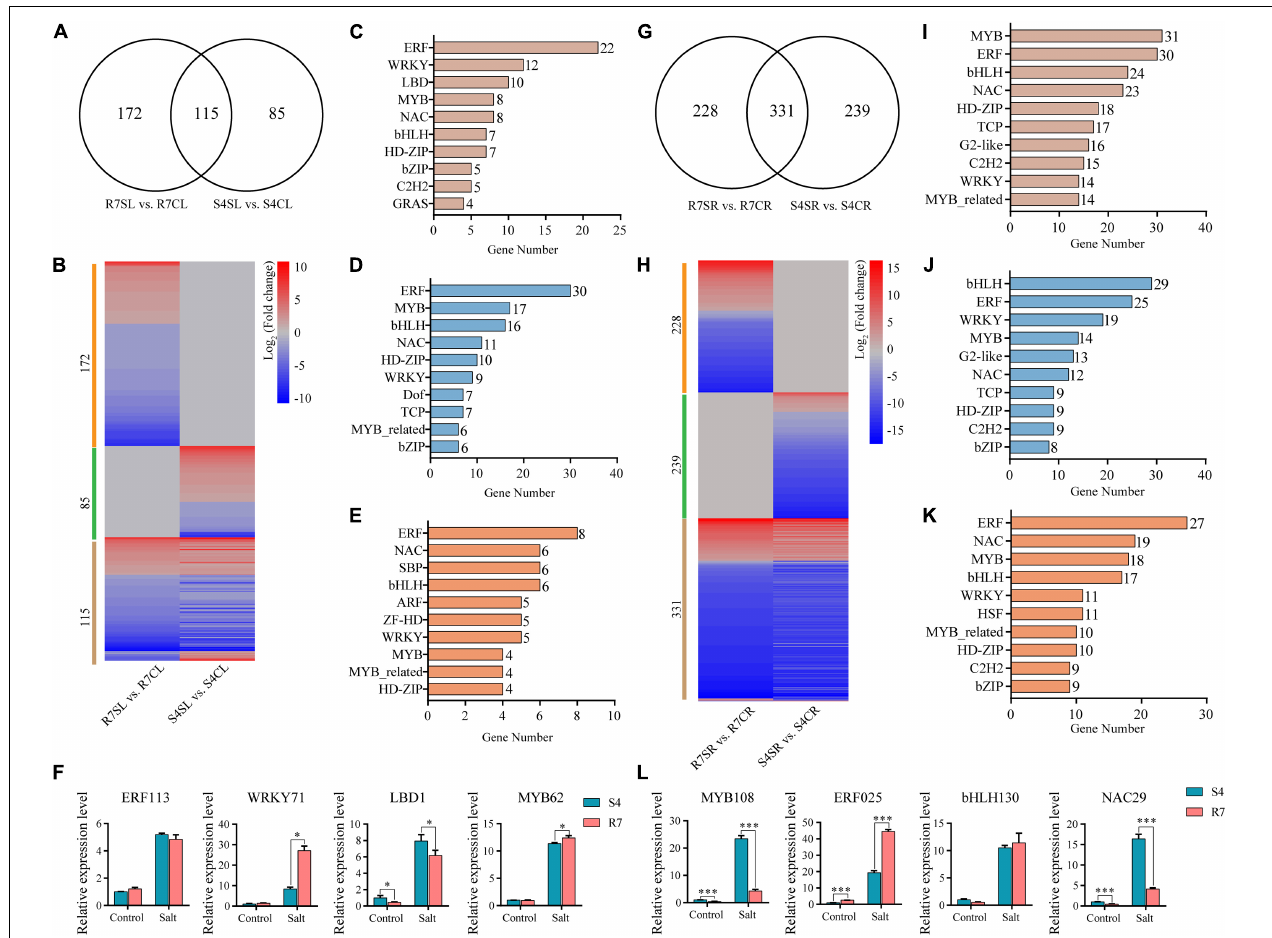
FIGURE 7 | Analysis of the differentially expressed transcription factors (TFs) in R7 and S4. (A,G) Venn diagrams showed the distribution of salt-induced TFs in R7 and S4 leaves and roots. (B,H) Heatmap showed the fold change of salt-treated R7 and S4 roots and leaves compared to their corresponding non-treated samples. (A–E, I–K) The top 10 TF families (ranked by gene number) in specific and common TFs among different comparisons. (F,L) The relative expression levels of the shared differentially expressed TFs in leaves and roots. ∗ P < 0.05 and ∗∗∗ P < 0.001 represented significant